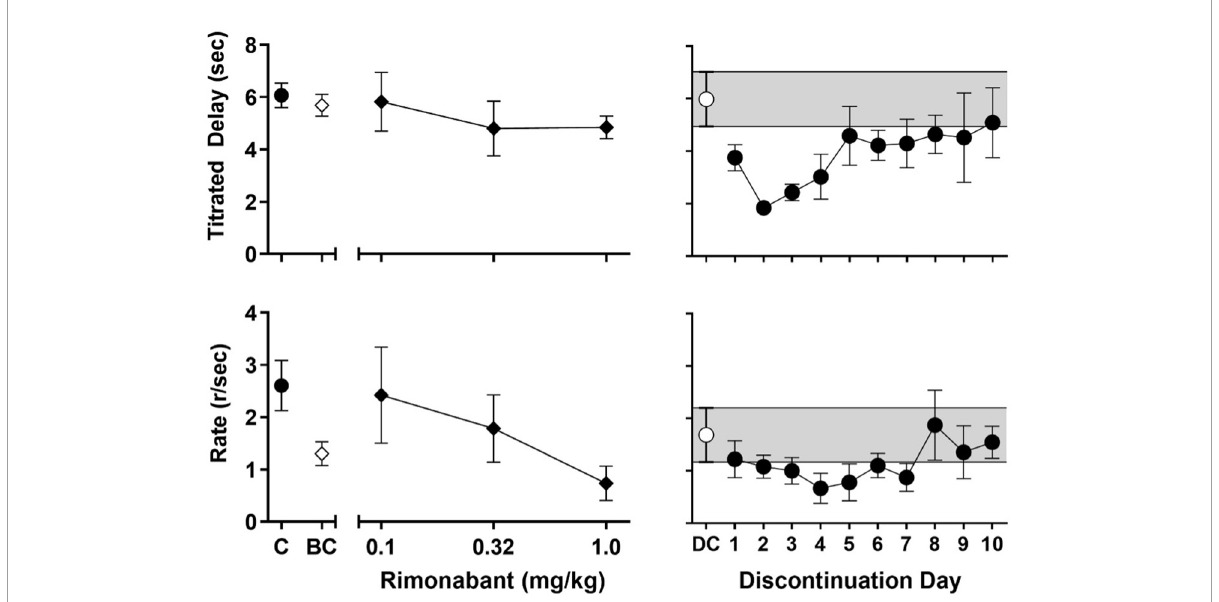
FIGURE3 Left panels: Effects of rimonabant administration on session-wide mean ( ± SEM) titrated duration values (upper-left panel) and mean ( ± SEM) response rate values (lower-left panel) in the TDMTS task before chronic exposure (BC; 1 mg/kg) and in dose-response determinations during chronic treatment (black diamonds; 0.1–1.0 mg/kg). For ease of comparison, values obtained during control sessions prior to drug exposure (C; black circles) are also shown. Right panels: Session-wide mean ( ± SEM) titrated duration values (upper-right panel) and mean ( ± SEM) response rate values (lower-right panel) in the TDMTS task during the last 5 sessions of chronic AM2389 exposure (DC; while circle) and during the 10 days following abrupt AM2389 discontinuation (black circles) N = 4.